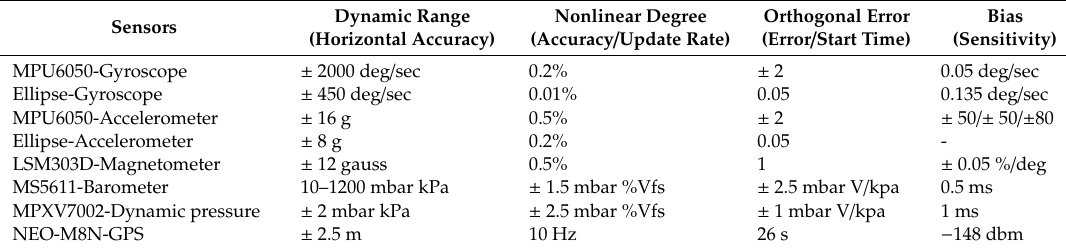
Table 3. Various sensors with measurement performance.